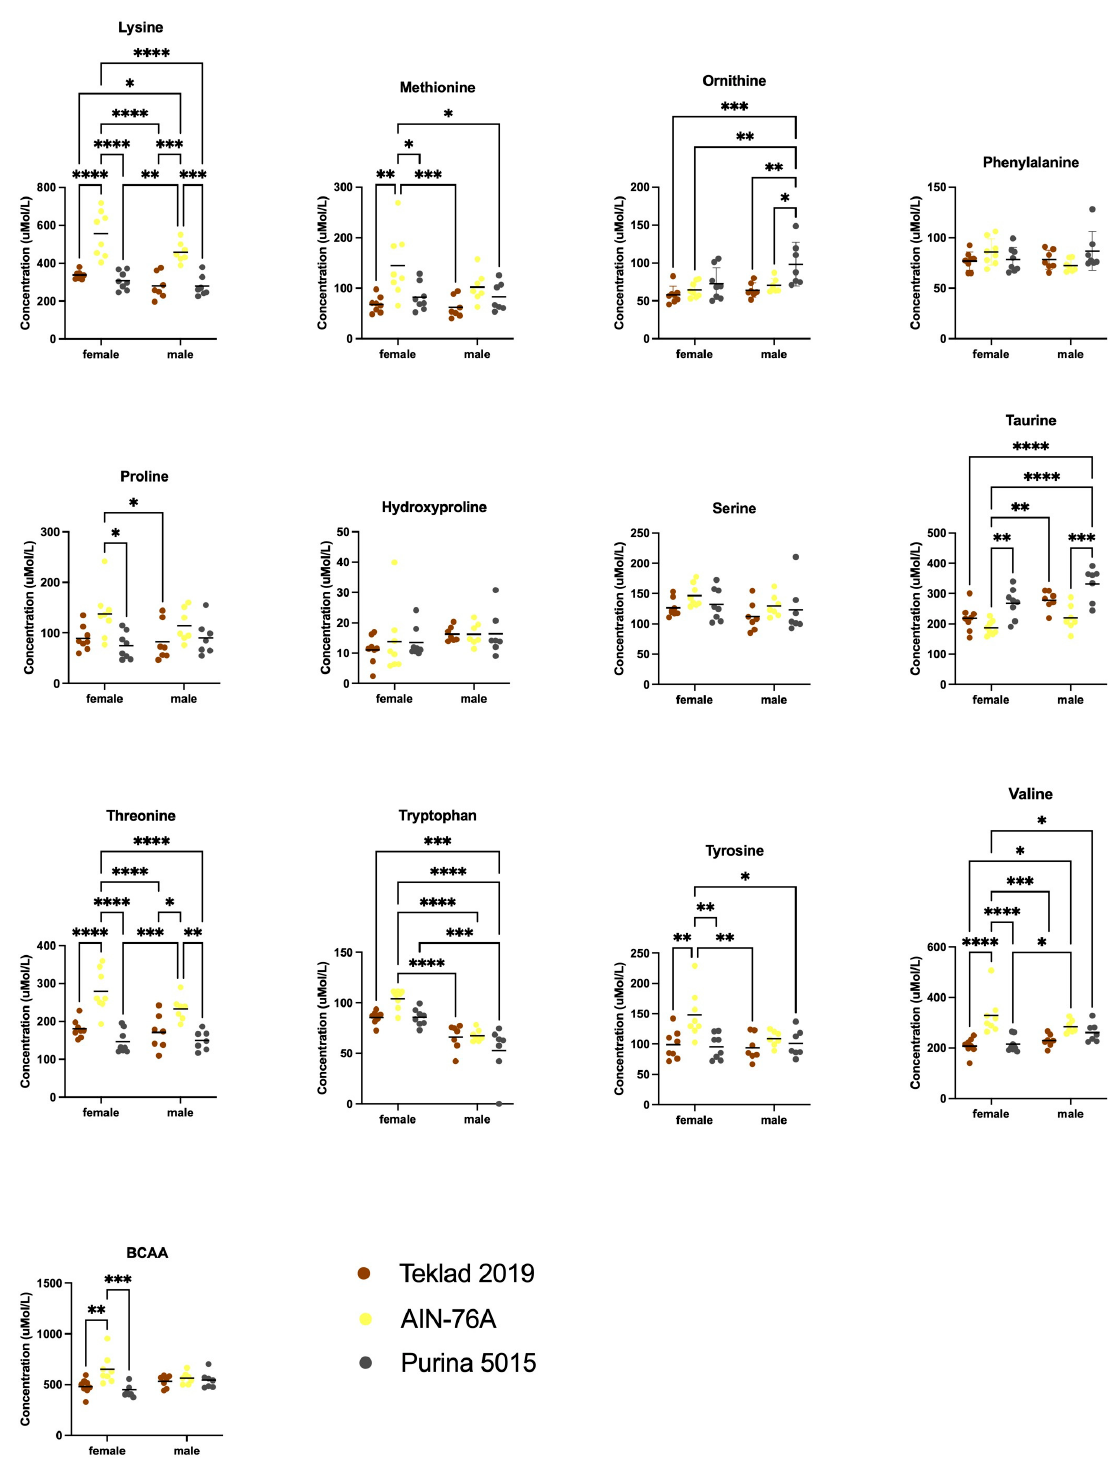
Figure 7. Blood plasma amino acid levels as an effect of diet. Blood was collected from male and female7C57BL/6J mice at euthanization and quantitated for plasma amino acids by ion-exchange chromatography as an effect of diet (Teklad 2019, AIN-76A or Purina 5015). Statistics were determined by 2-way ANOVA and Tukey’s multiple comparison tests (see Table S1) denoted by p < 0.05 (*), p < 0.01 (**), p < 0.001 (***) and p < 0.0001 (****). See Figure 6 for remaining data.